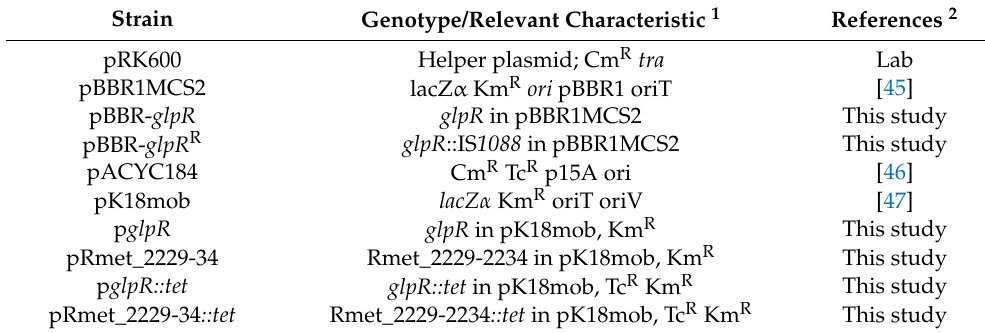
Table 2. Plasmids used in this